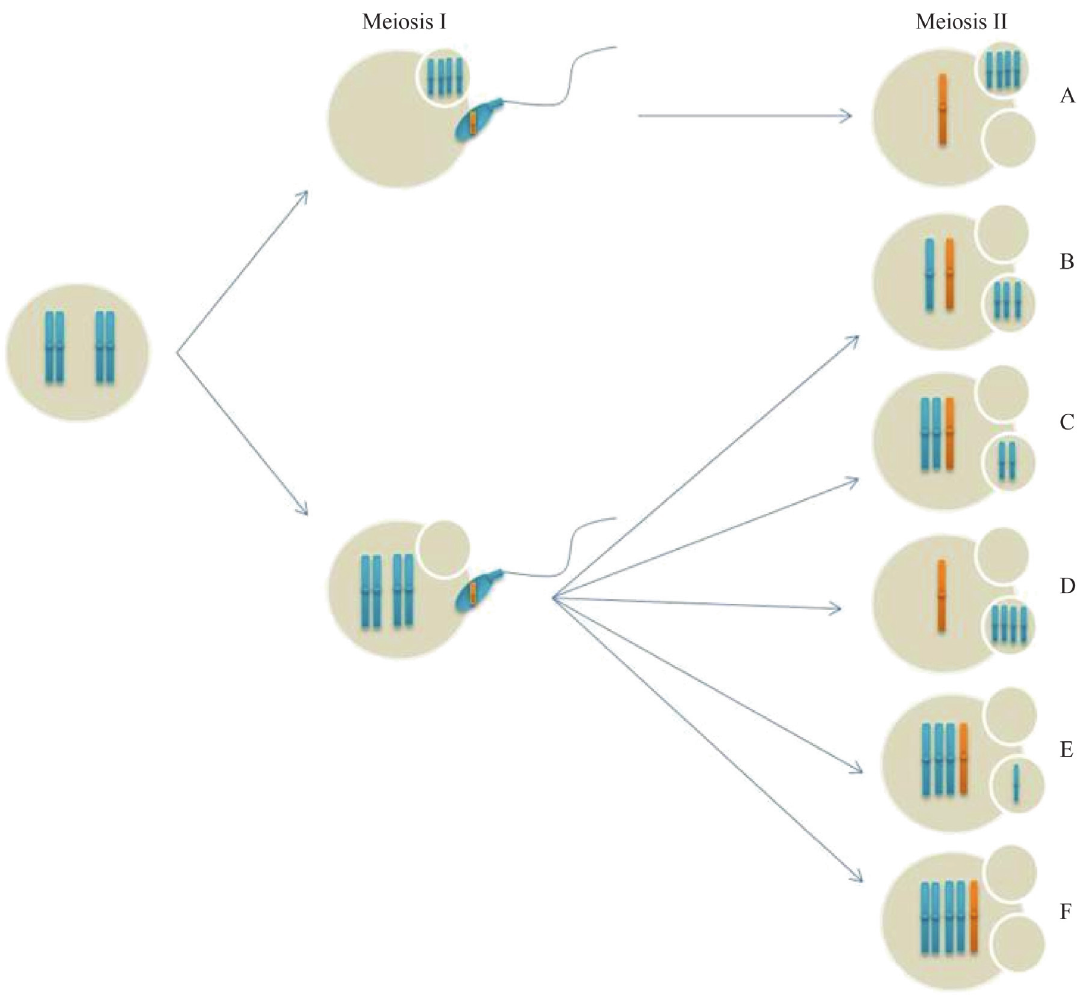
Figure 2 - Possibilities of segregation during second division from an abnormal oocyte by non-disjunction. One of the six possibilities is normal